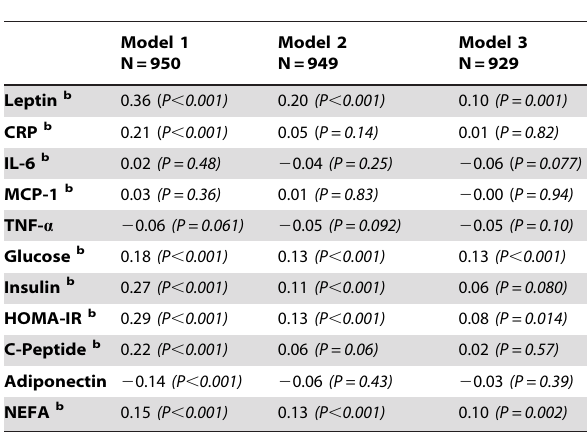
Table 3. Association of plasma tCys with circulating inflammatory markers, adipokines and insulin-resistance- related parameters.